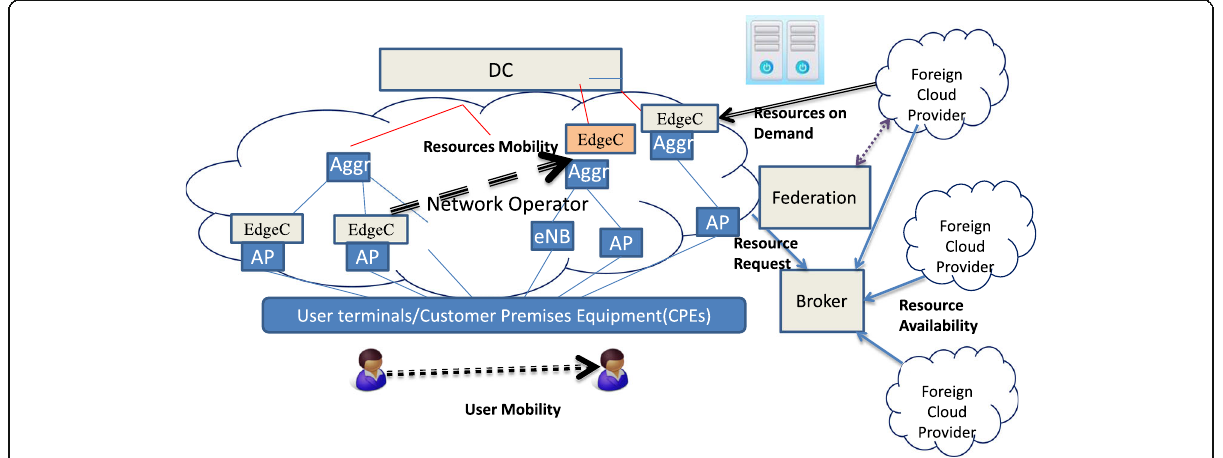
Fig. 2 Distributed cloud federation and service brokerage